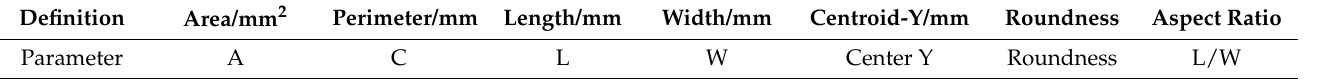
Table 1. The necessary characteristic parameters of the bubble.